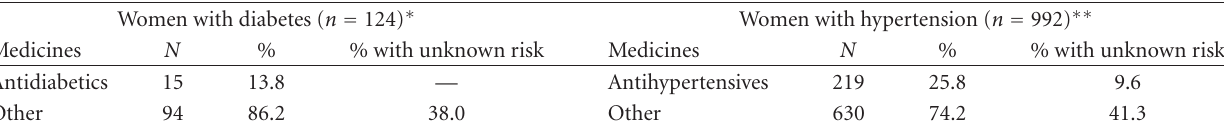
Table 5: Medicine use among hypertensive and diabetic women. Birth Cohort of Pelotas, RS 2004. Women with diabetes ( n = 124) ∗ Women with hypertension ( n = 992) ∗∗